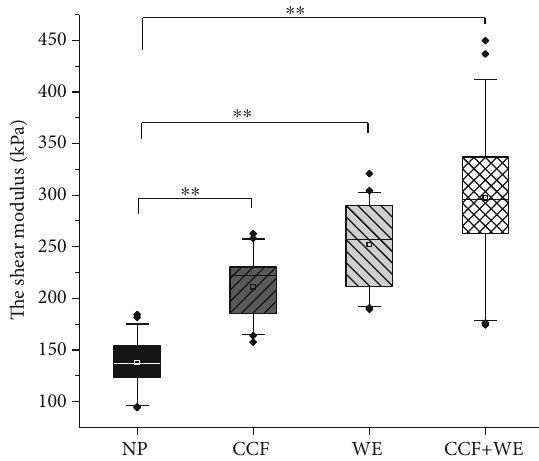
Figure 4: Box plot of the shear modulus of the median nerve at the midpoint of the forearm for 4 variants of the upper limb neurodynamic test (black: neutral posture (NP); dark gray: contralateral cervical fl exion (CCF); light gray: wrist extension (WE); white: contralateral cervical fl exion+wrist extension (CCF+WE)). ∗∗ indicates p < 0 : 001